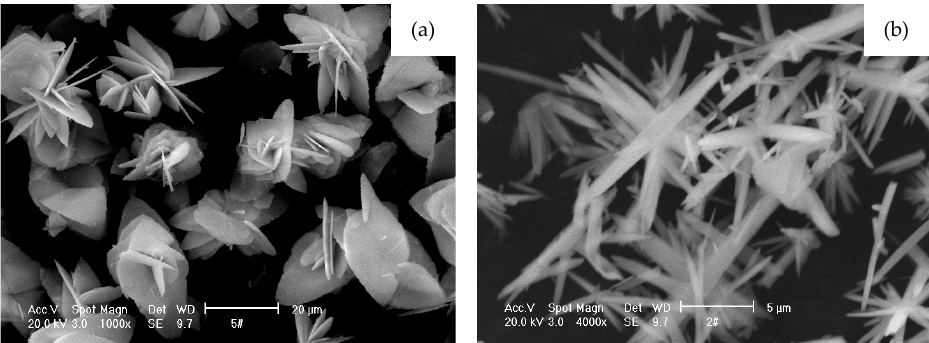
Figure 13. SEM of rare earth carbonate precipitate in the absence ( a ) and presence ( b ) of aluminum ions.